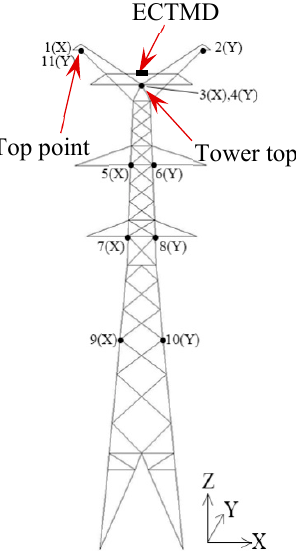
Figure 10. Locations of acceleration sensors.